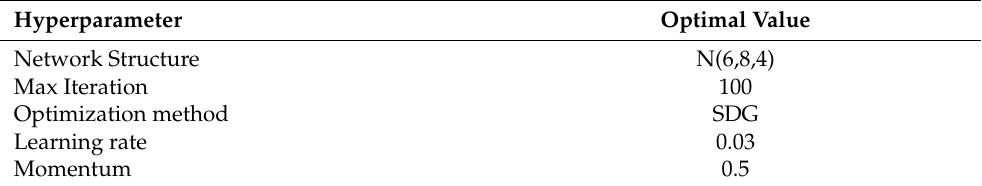
Figure 8. ANN architecture. Table 6. ANN optimal Hyperparameter.